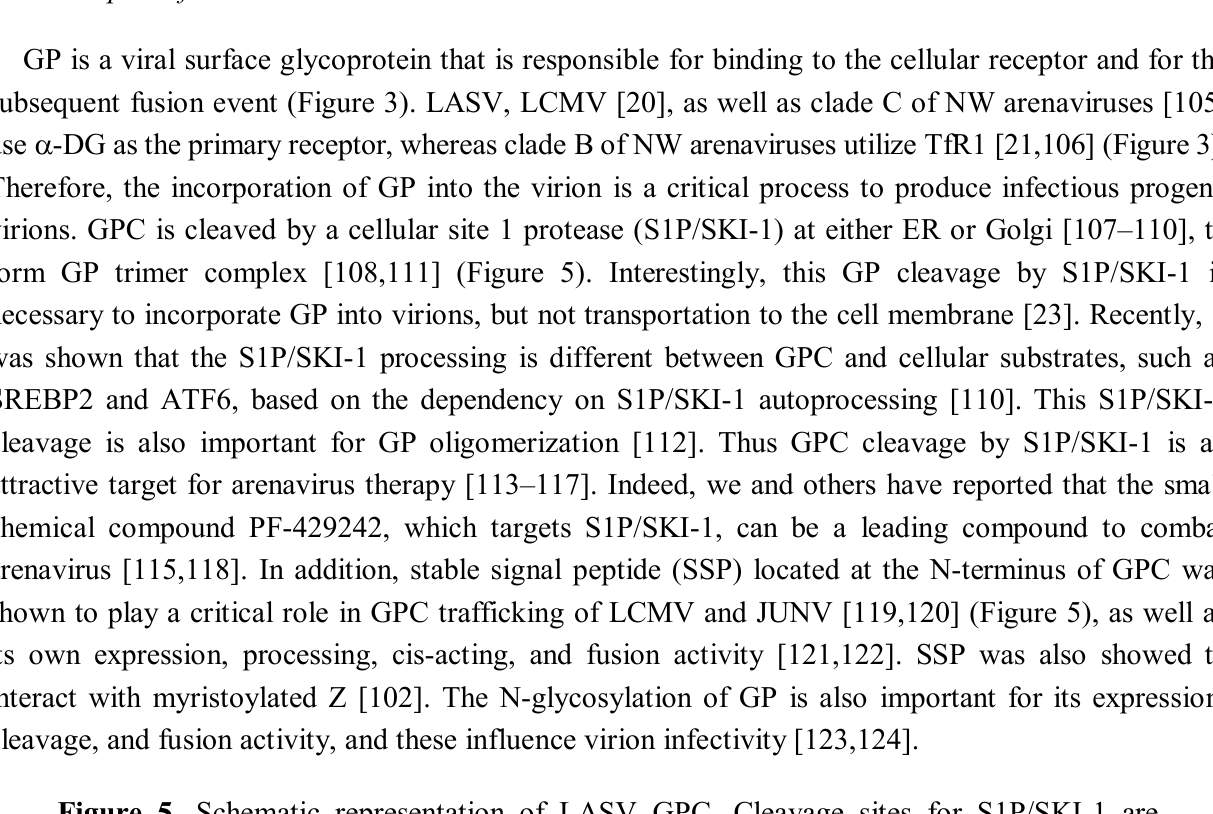
Figure 5. Schematic representation of LASV GPC. Cleavage sites for S1P/SKI-1 are indicated by the red arrows. The sequences of LCMV and JUNV cleavage sites are also indicated. SSP: stable signal peptide; TM: Transmembrane